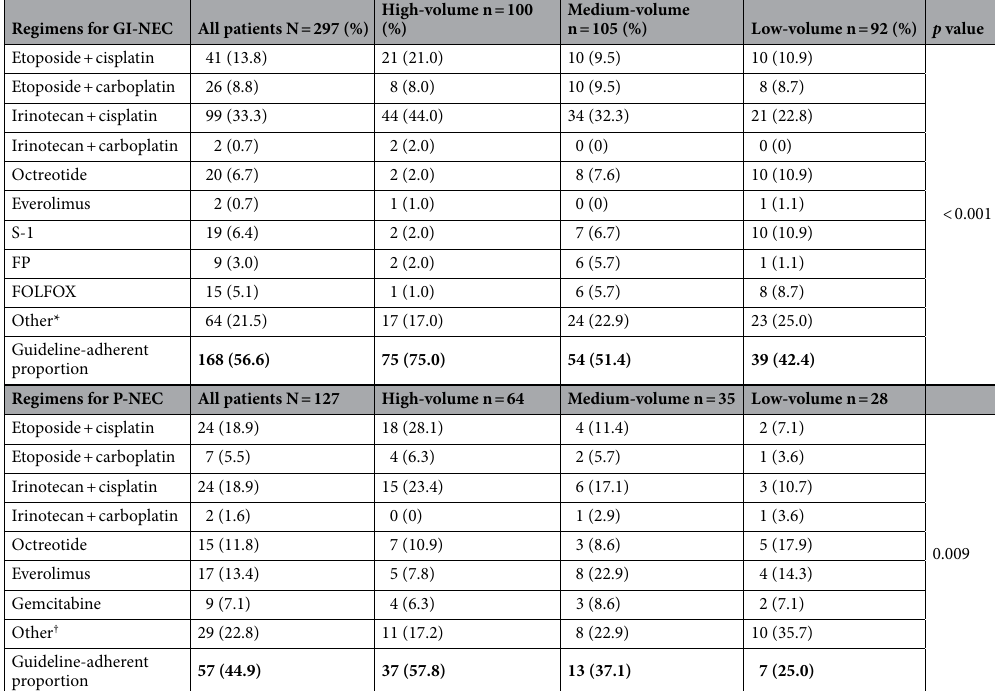
Table 4. Real-world selection of first-line chemotherapy regimens for patients with GEP-NEC according to hospital volume. FOLFOX 5-fluorouracil, leucovorin and oxaliplatin, FP 5-fluorouracil plus cisplatin, GEP gastroenteropancreatic; GI-NEC gastrointestinal neuroendocrine carcinoma, P-NEC pancreatic neuroendocrine carcinoma, S-1 tegafur-gimeracil-oteracil. *Capecitabine + oxaliplatin + bevacizumab, S-1 + oxaliplatin + bevacizumab, capecitabine, capecitabine + cisplatin, capecitabine + cisplatin + trastuzumab, capecitabine + oxaliplatin, cisplatin, docetaxel + cisplatin + fluorouracil, docetaxel + cisplatin + S-1, doxorubicin + cisplatin + fluorouracil, cisplatin + S-1, cyclophosphamide + doxorubicin + vincristine, docetaxel, etoposide, fluorouracil, fluorouracil + irinotecan, fluorouracil + nedaplatin, fulvestrant, imatinib, irinotecan, miriplatin, S-1 + oxaliplatin, paclitaxel, panitumumab, pirarubicin, tegafur/uracil. † Epirubicin, epirubicin + mitomycin, cisplatin, fluorouracil + irinotecan + oxaliplatin, fluorouracil + oxaliplatin, gemcitabine + S-1, sunitinib. Significant values are in bold.